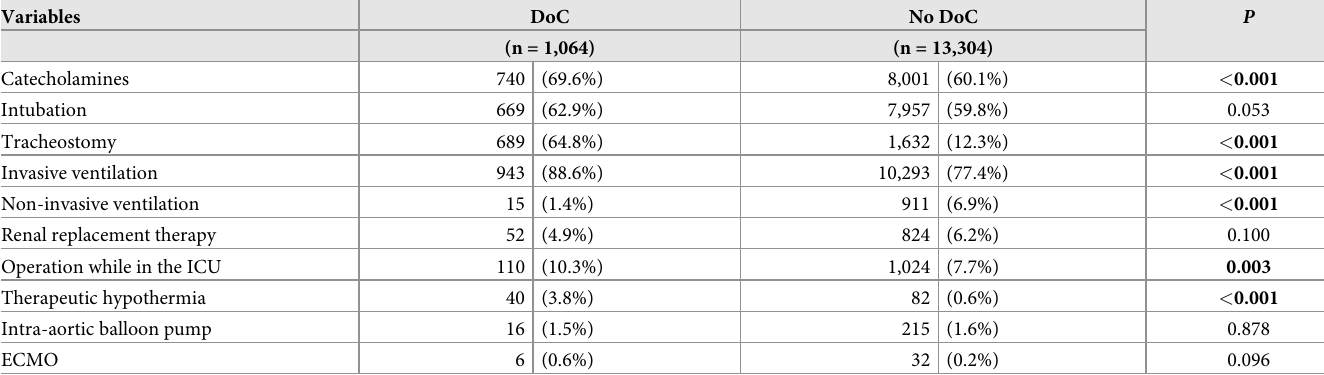
Table 3. ICU treatment in patients discharged from the ICU with or without DoC.